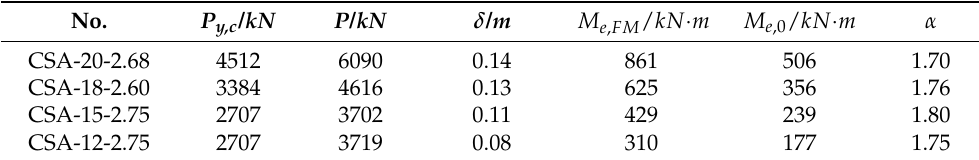
Table 2. Key geometric dimensions and results of the